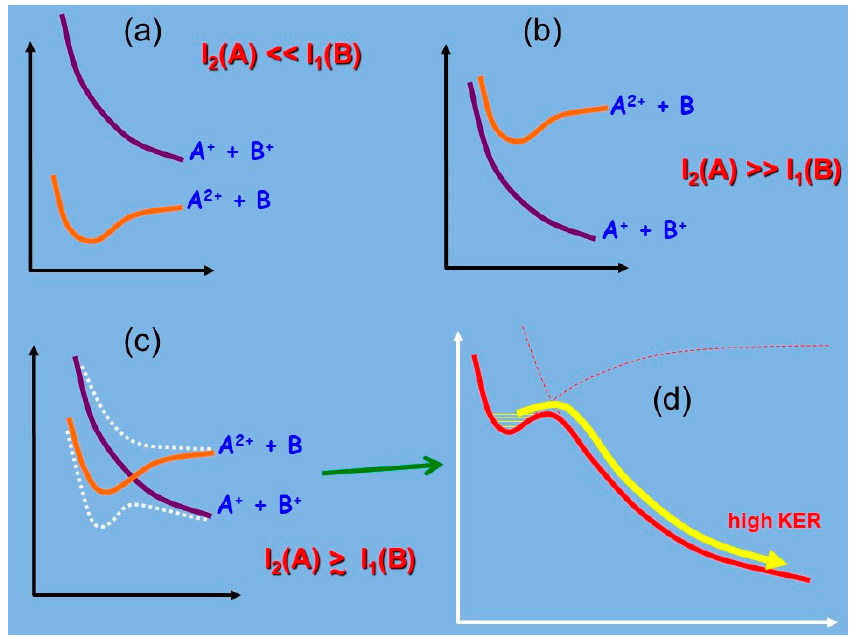
Figure 1. Scheme of the potential energy curves for AB 2+ diatomic molecular dications: ( a ) the case of the thermodynamically stable species; ( b ) unstable species; ( c ) the metastable dications resulting from the avoided crossing of the involved potential energy curves; ( d ) the potential energy curve coming out from case ( c ) producing A + and B + fragments with high kinetic energy release (KER) by Coulomb explosion. In all panels, the interatomic distance is shown in the x axis while the energy is shown in the y axis.